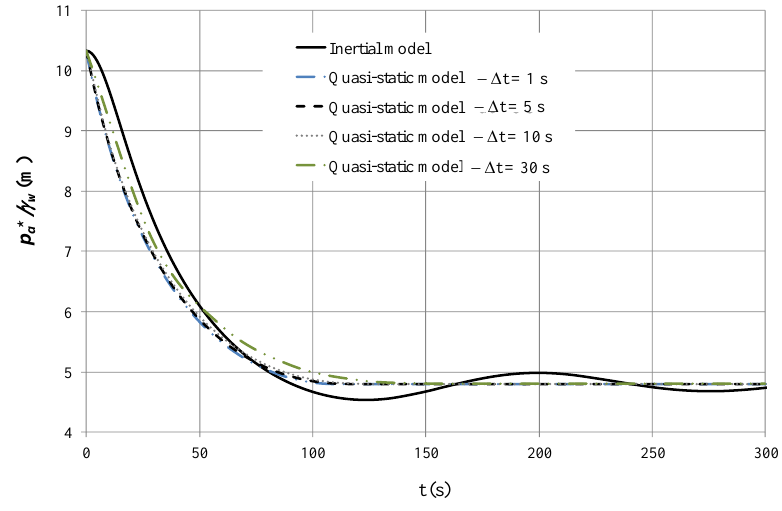
Figure 8. E ff ect of time step during a draining process. Figure 8. Effect of time step during a draining process. Figure 8. Effect of time step during a draining process.